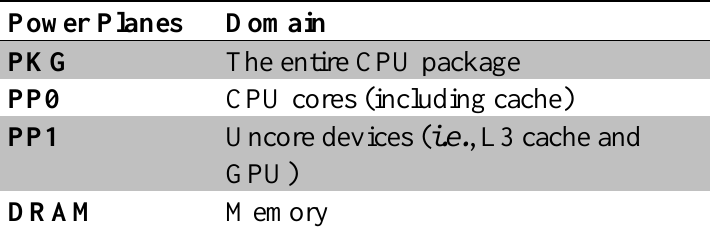
Table 1. RAPL measurement